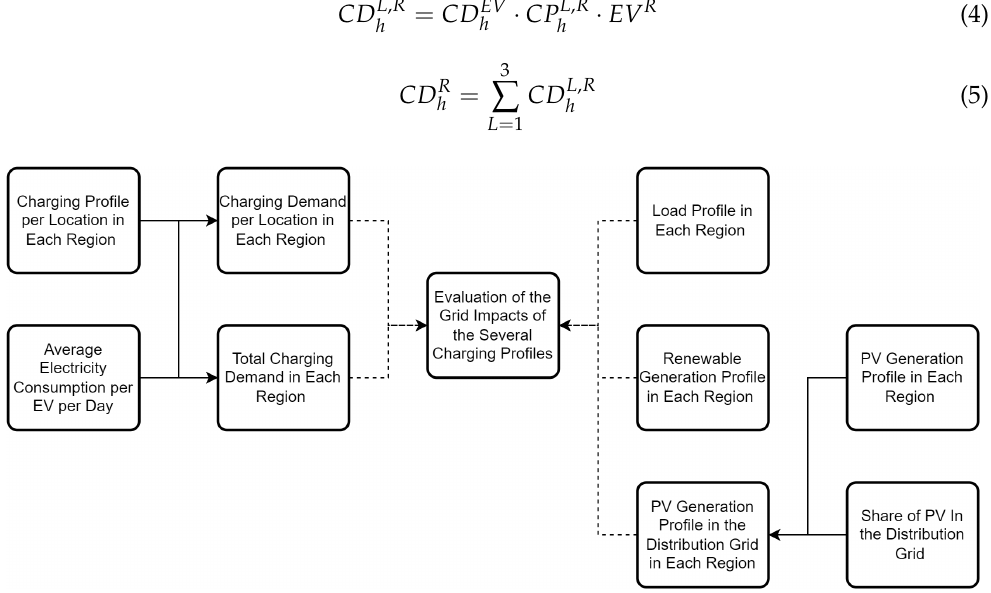
Figure 4. Evaluation of the impact on the electrical grid. The profiles for the charging demand per location in each region and the total charging demand in each region were then compared with the load profiles in each region, as well as with the profiles of renewable generation in each region [28]. The charging profiles were also compared with the solar photovoltaic (PV) generation profile at the distribution grid level, using the PV generation profile in each region [28] and the share of PV connected to the distribution grid [31]. The future profiles were also derived considering the defined projections for the future generation mix (capacity by power plant type) and demand of the U.S. Energy Information Administration [30], assuming a variation in the generation and demand during the year proportional to the actual